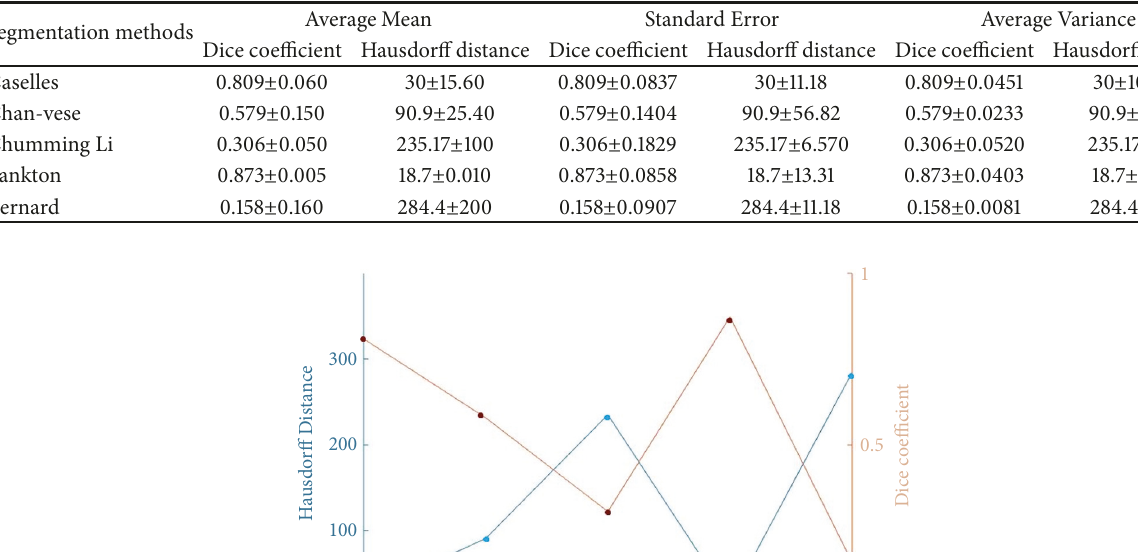
Table 2: Statistical values of performance metrics for segmentation techniques.